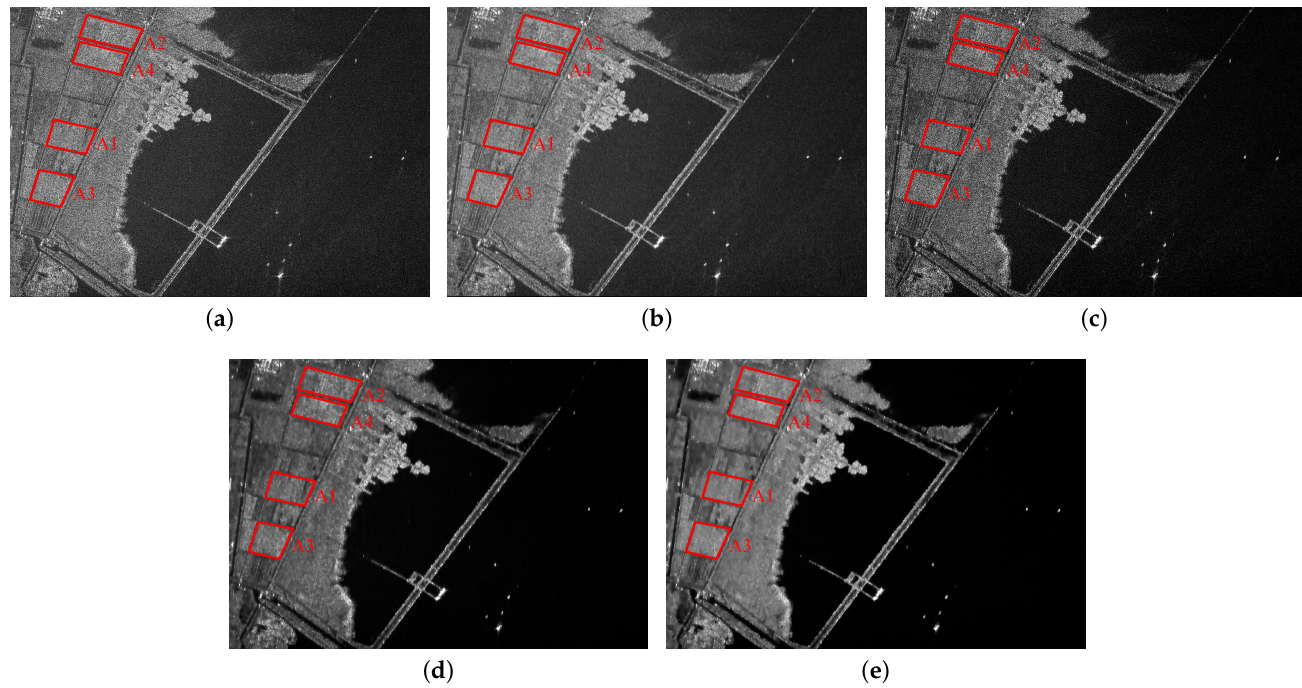
Figure 5. Experimental results for data 1 under full sampling condition. ( a ) Chirp scaling. ( b ) CSA + multilook processing using a 5 by 5 window. ( c ) L 1 regularization. ( d ) L 1 and TV regularization. ( e ) Nonconvex and TV regularization. The vertical direction of the image is the azimuth direction, and the horizontal direction is the range direction. SAR data 1 occupies 1404 (azimuth) × 3941 (range) sampling points, and the size of the corresponding scene is 8673 m (azimuth) × 8867 m (range). All the images are plotted with the same color map.